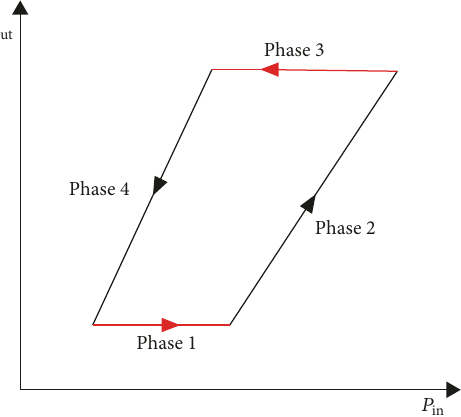
Figure 6: Relation between position input and position output